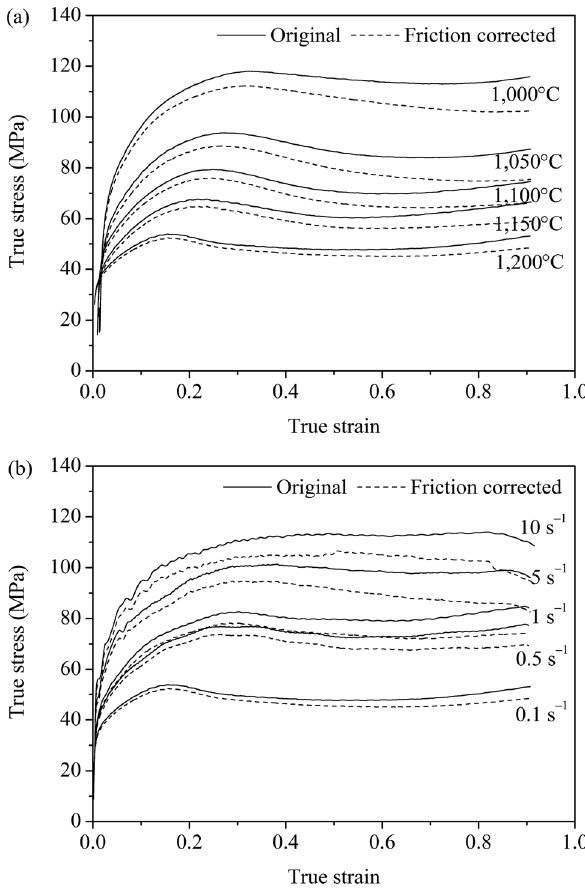
Figure 2: Comparison between the friction-corrected and measured flow stresses: (a) _ ε = 0.1 s − 1 ; (b) T = 1,200°C.